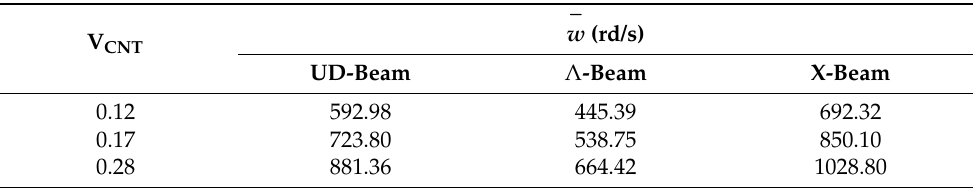
Table 4. The resonance frequencies of reinforced composite beams for various volume fractions of CNTs ( L = 2 m, b = h = 0.1 m).